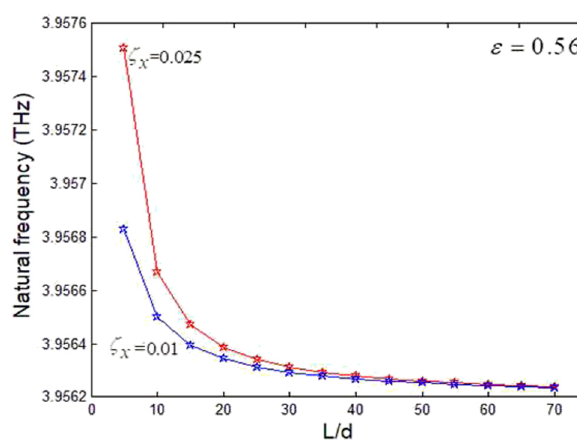
Figure 7: Variations in the natural frequency of irregular ( ε = 0.56 ) single - walled carbon nanotube against aspect ratio ( L / d ) under initial stresses ( ζ = 0.01, 0.025 )